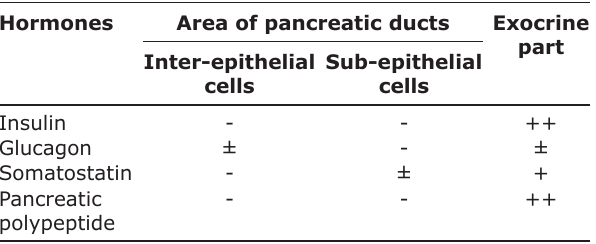
Table-2: Semiquantitative number of the endocrine cells in the pancreatic duct and exocrine part of the Sunda porcupine ( Hystrix javanica